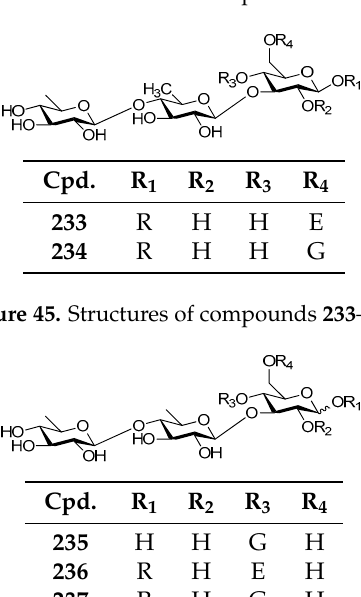
Figure 46. Structures of compounds 235 – 238 .